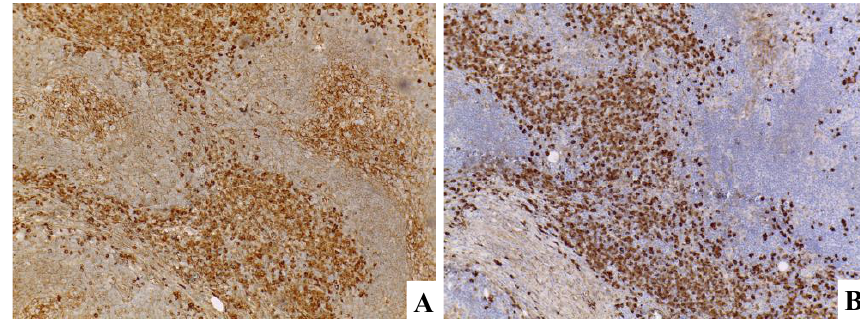
Figure 9. ( A ) IgG. ( B ) IgG4.